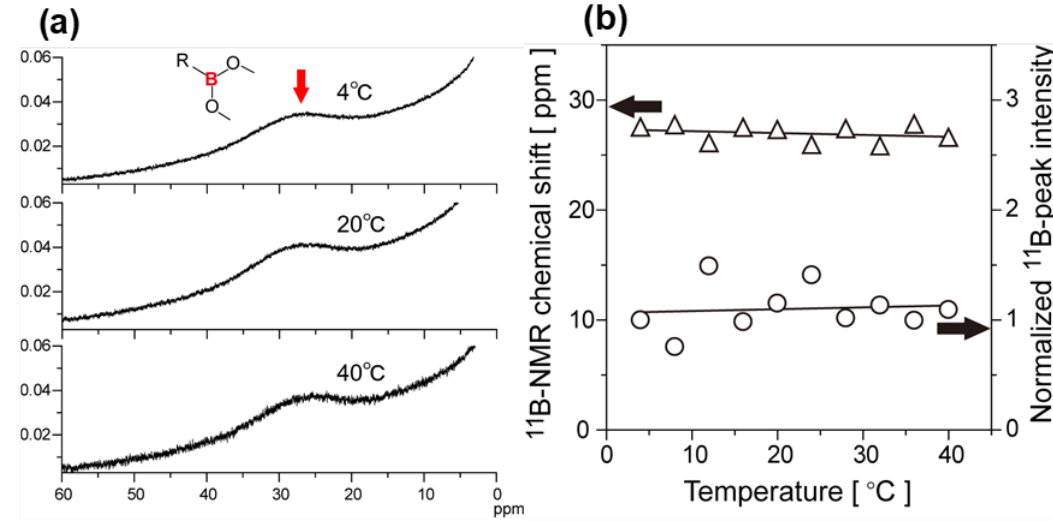
Figure 6. Temperature-variable 11 B-NMR spectra of poly(NIPAAm- block -NIPAAm- co -PBA) in D 2 O from 4 to 40 ◦ C ( a ) and the 11 B-chemical shift (open triangle) and normalized peak area intensities (open circle) of boronic-acid groups against BF 3 · OEt 2 ( b ). BF 3 · OEt 2 was used as the external reference.